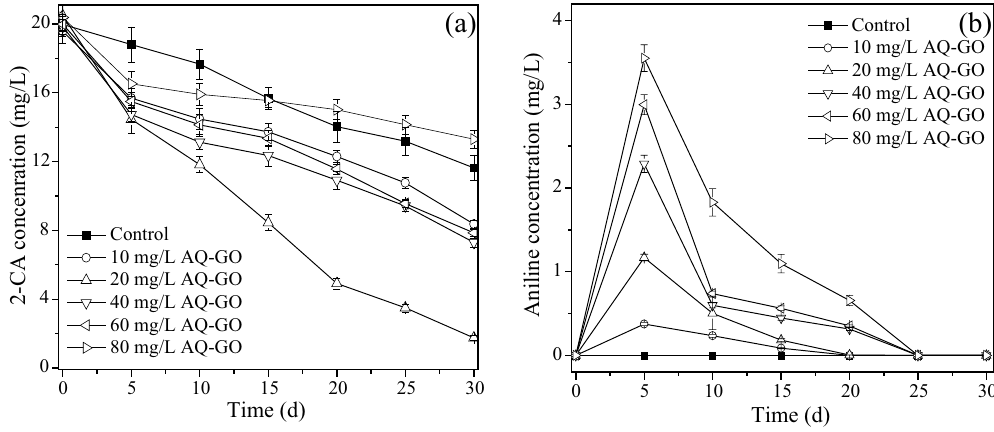
Figure 2. Effect of AQ-GO concentration on the dechlorination and degradation of 2-CA in 30 d. ( a ) 2-CA degradation; ( b ) aniline formation and degradation. Error bars show one standard